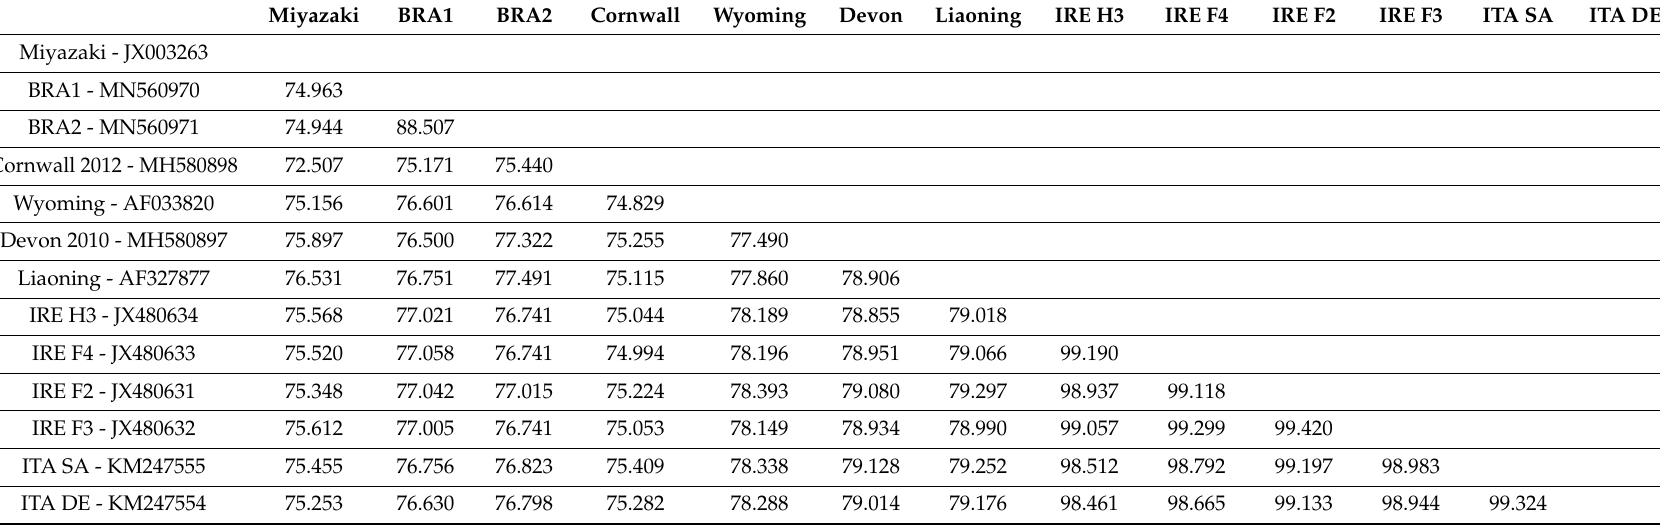
Table 3. The identity matrix with EIAV genomes shows the percentage of bases / residues that are